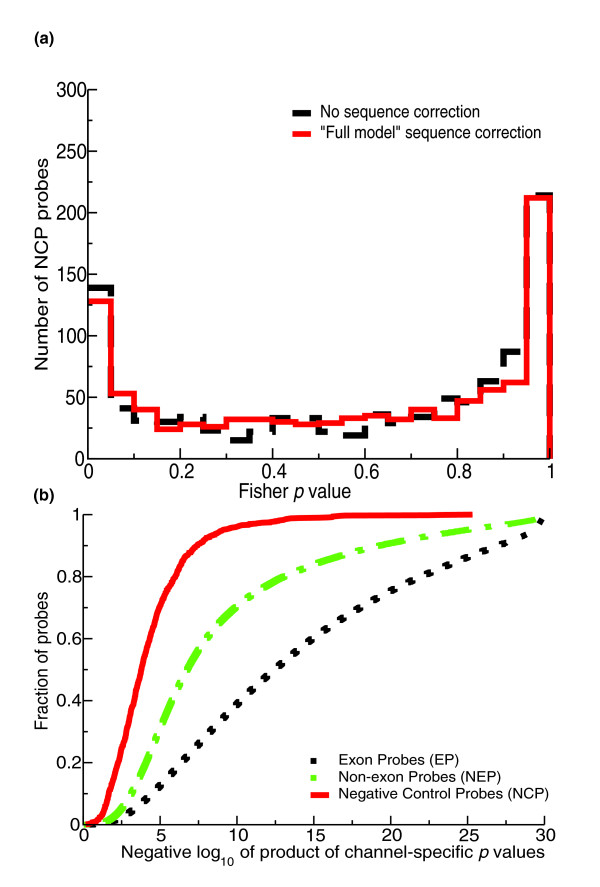
Combining information from replicate experiments. (a) Distribution of Fisher p values for NCPs, obtained by taking the product of channel-specific p values and comparing it to the product of random numbers drawn from a uniform distribution (see [28]). The solid line corresponds to probe signal intensities that were first corrected for probe sequence bias using the Full Position-specific model (see Materials and methods); the dashed line corresponds to uncorrected intensities. (b) Distribution of the negative log of products of single-channel p values for different probe populations.